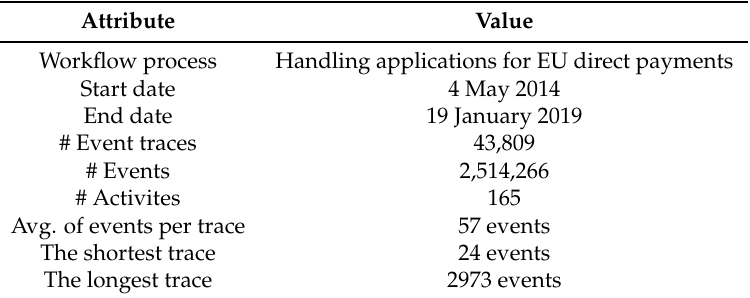
Table 1. Summary of the BPI Challenge (BPIC) 2018 dataset.